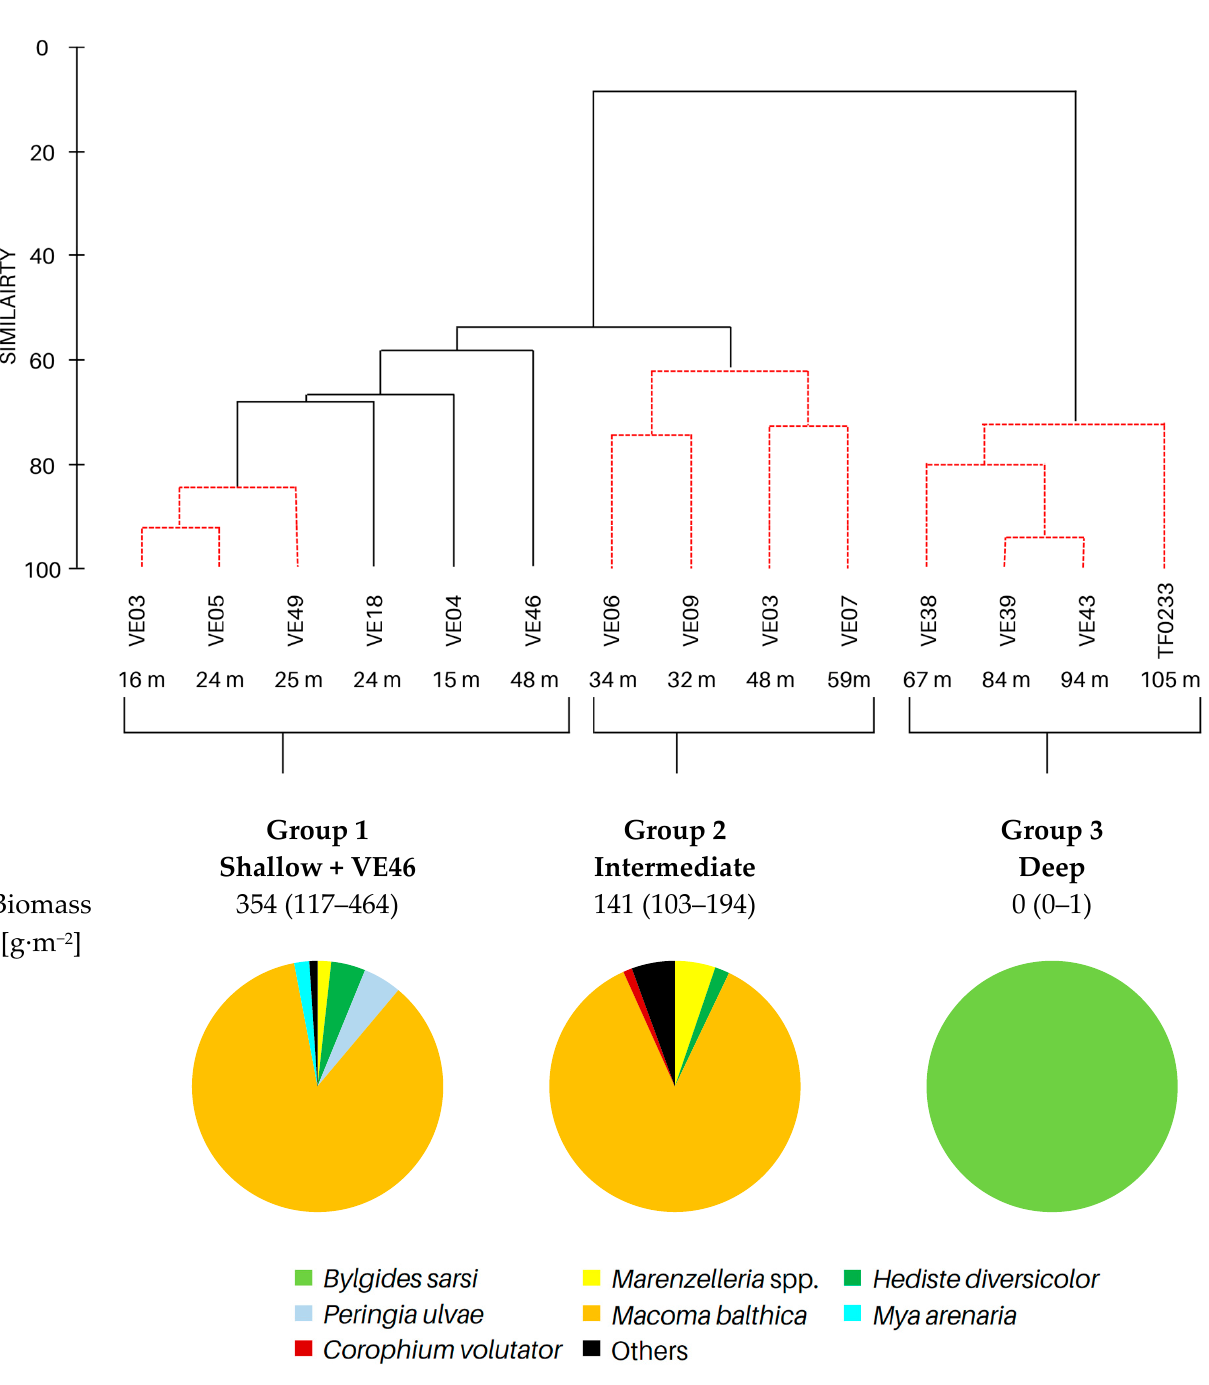
Figure 3. Groups of sites distinguished by cluster analysis on the basis of taxonomic composition and biomass (data transformation: √ ): top—cluster similarity of the study sites; bottom—contribution of taxa in macrofaunal biomass in three groups of sites.